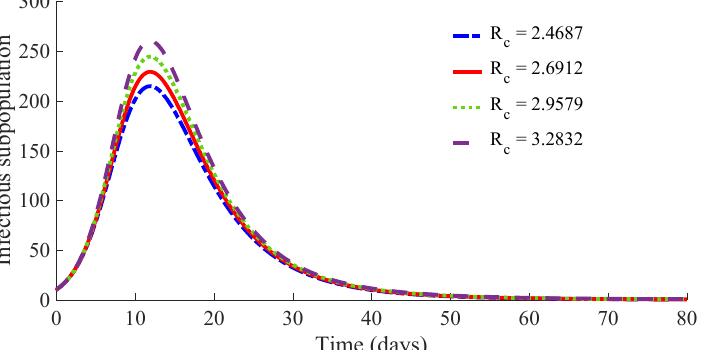
Figure 10. Time evolution of the infectious subpopulation for the four considered values of the control parameter c 2 .